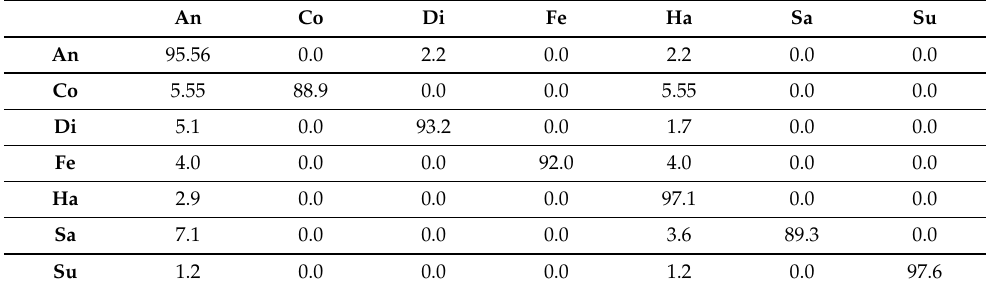
Table 5. Confusion matrix: SVM-based facial displacement (CK+) from the landmark displacement.